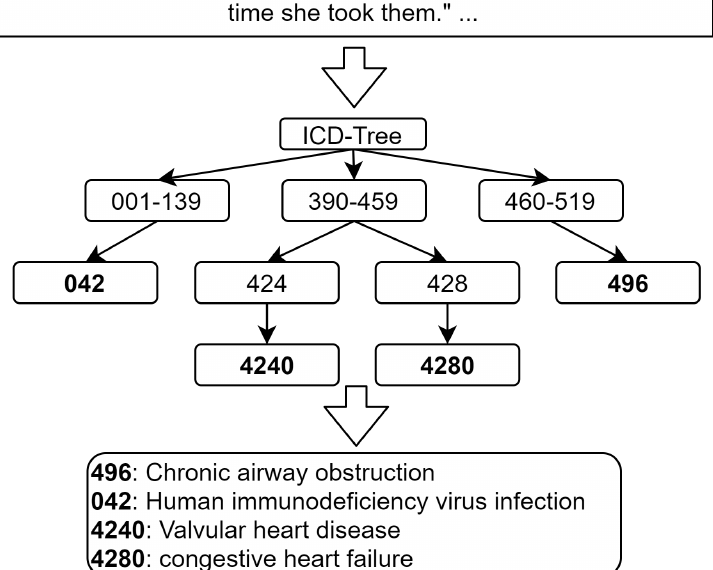
Figure 2. Example snippet of discharge summary from the MIMIC-III dataset with corresponding target International Classification of Diseases (ICD)